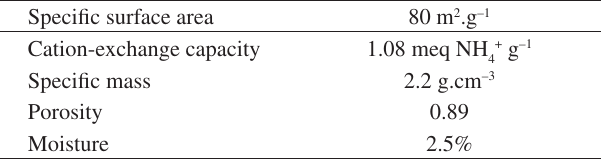
Table 1. Characterization data of natural zeolite.